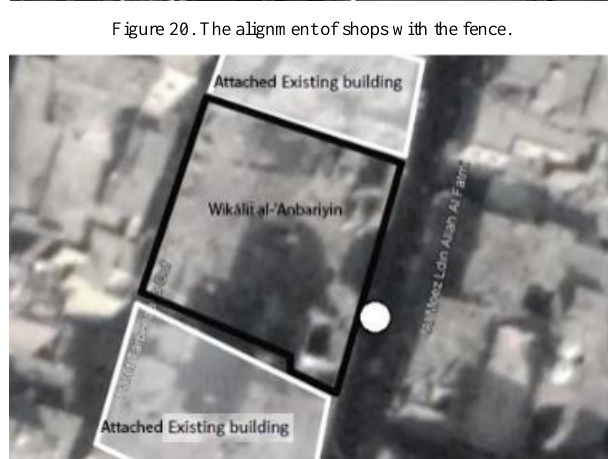
Location of the image: ạl-Mu’iz Street.